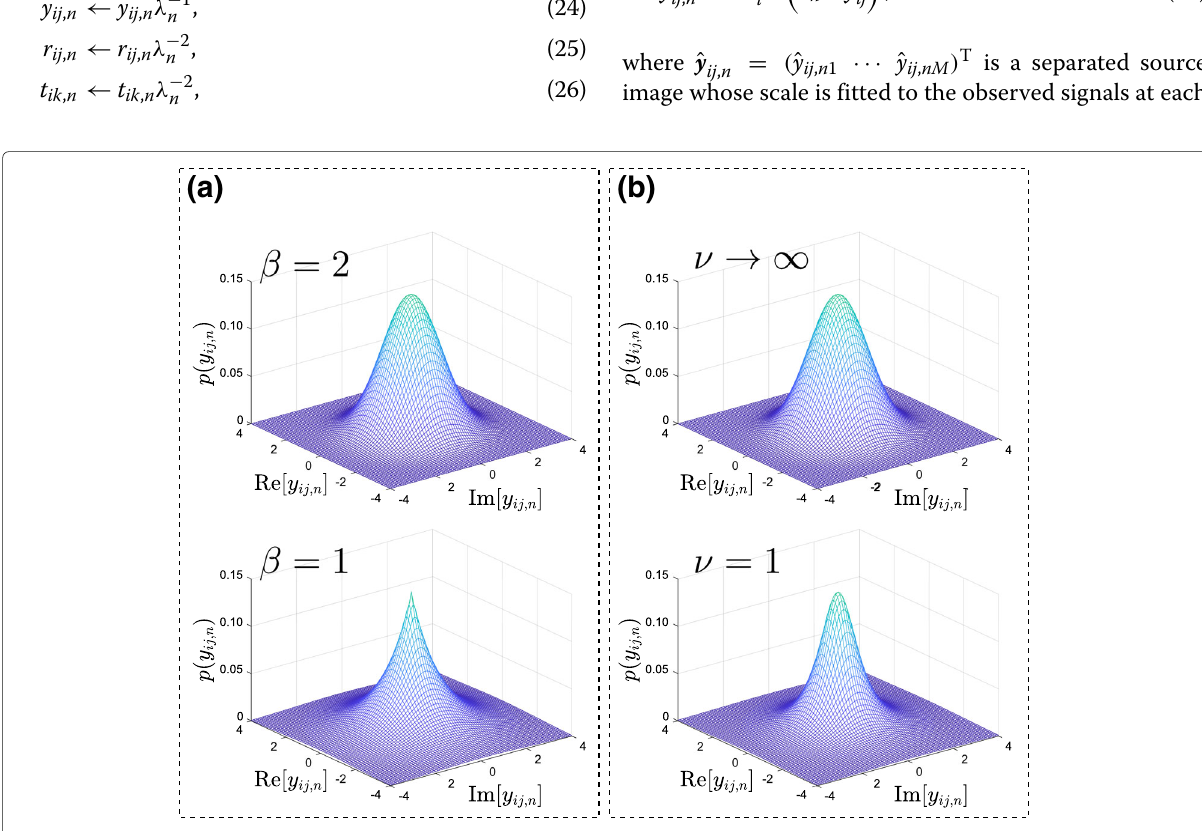
Fig. 4 Source models assumed in proposed methods: a isotropic complex GGD and b isotropic complex Student’s t distribution. The GGD includes Gaussian and Laplace distributions as special cases, and the Student’s t distribution includes Gaussian and Cauchy distributions as special